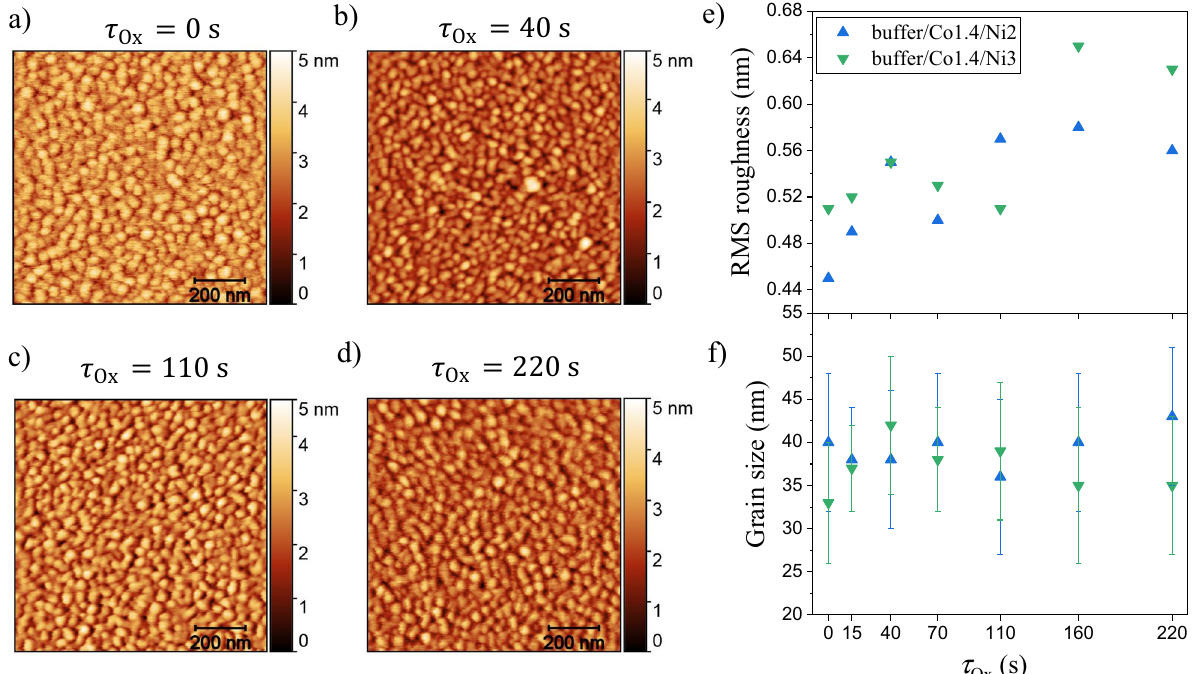
Figure 1. AFM results obtained for the buffer/Co 1.4 nm/Ni 2 nm and buffer/Co 1.4 nm/Ni 3 nm systems: ( a – d ) surface topography of buffer/Co 1.4 nm/Ni 2 nm for different oxidation times τ Ox = 0 (as deposited state), 40, 110 and 220 s, respectively; ( e ) roughness of layers and ( f ) grain sizes as a function of τ Ox